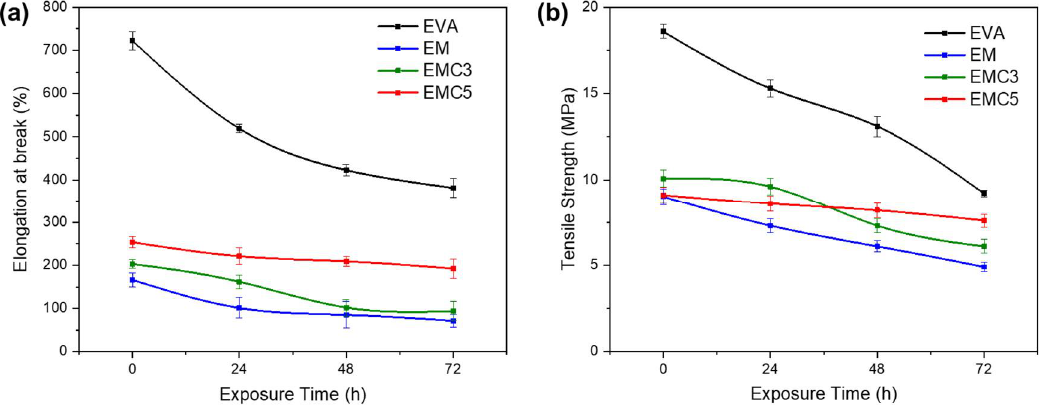
Figure 9. The tensile properties of the samples before and after exposure under UV by different times: ( a ) Elongation at break and ( b ) Tensile strength.